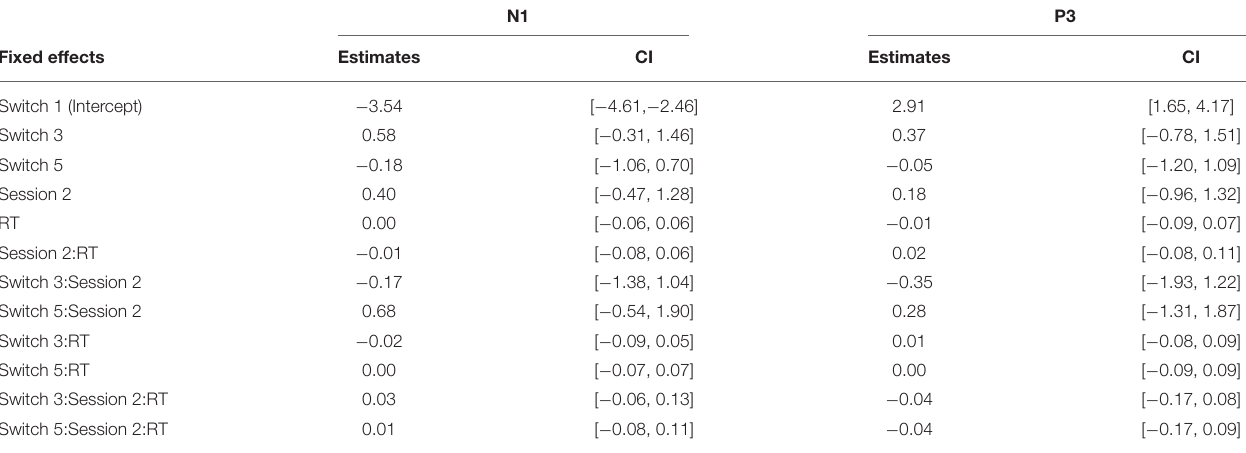
TABLE 6 | Estimated coefficients of fixed effects in LMEs for EEG responses relative to feedback onset.